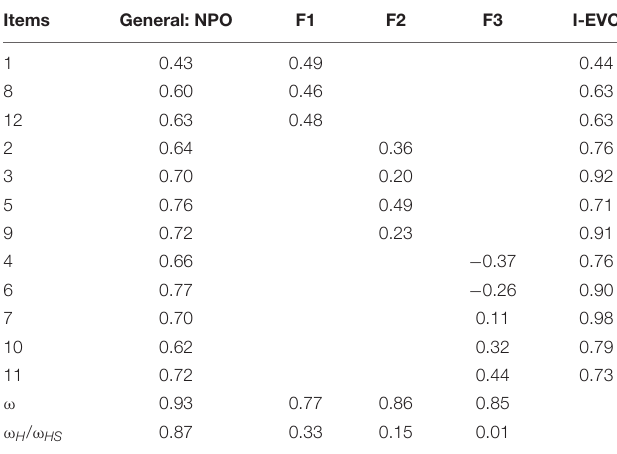
TABLE 3 | Standardized factor loadings for the bifactor model of